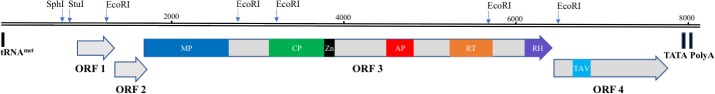
Schematic representation of the genome organization of Dioscorea nummularia-associated virus (DNUaV).Large arrows represent the putative ORFs. Conserved protein domains are shown: dark blue = movement protein (MP) domain corresponding to M1-E327 of CaMV ORF 2 protein; green = the putative coat protein (CP) domain corresponding to L261–N429 of the CaMV ORF 4 protein; black = zinc finger (Zn); red = pepsin-like aspartic protease (AP); orange = reverse transcriptase (RT); purple = RNase H (RH); light blue = transactivator (TAV) domain. The tRNAmet binding site (tRNAmet) and regulatory sequences including TATA box (TATA) and polyadenylation signal (PolyA) are also shown. The relative position of restriction sites based on the complete genome sequence are shown above the genome.